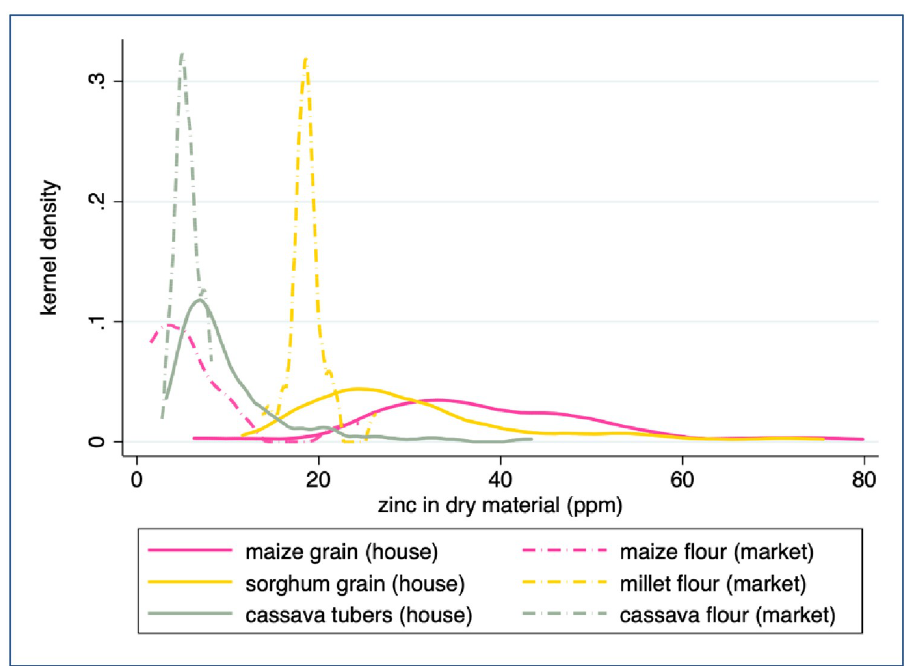
Fig 5. Zinc concentration in comparable farm-market samples. Values exceeding 80 ppm are not